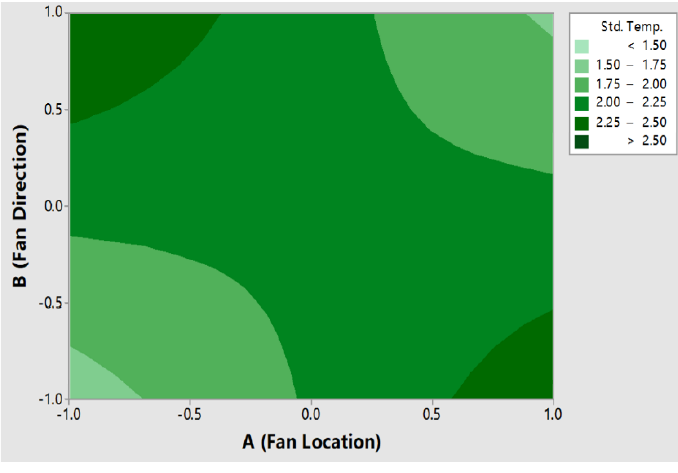
Figure 6. Contour plot of fan location and fan direction versus temperature deviation.